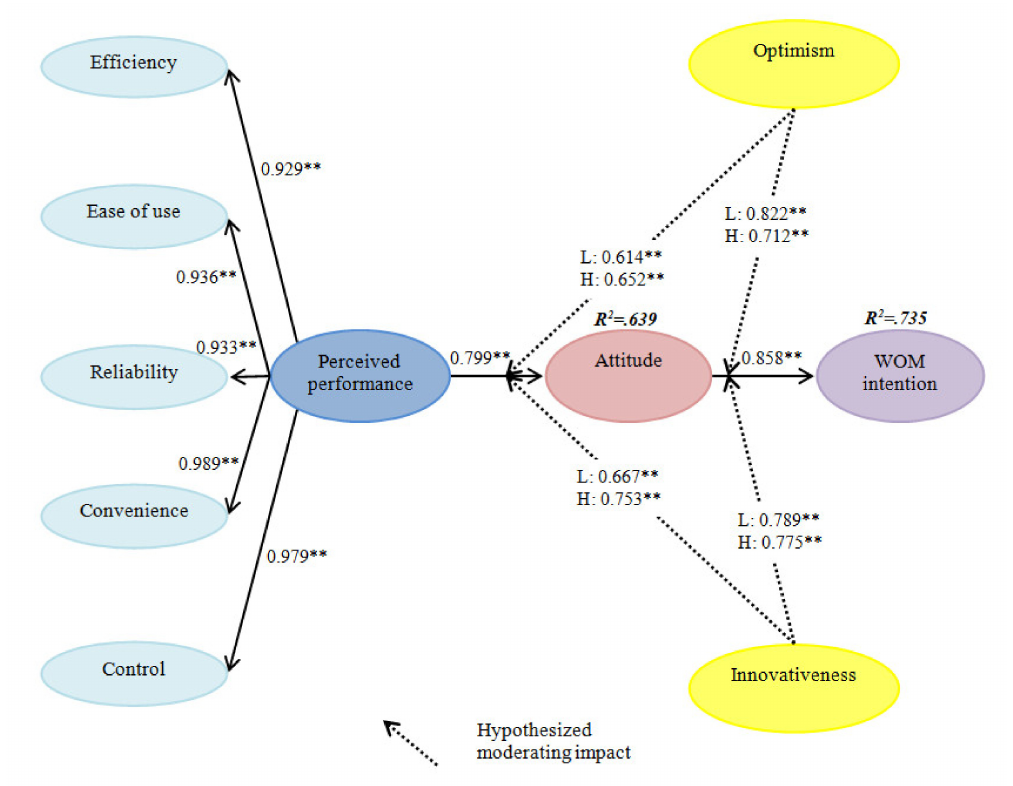
Figure 2. Standardized theoretical path coe ffi cients. Note 1: L = low level, H = high level. Note 2: ** p <